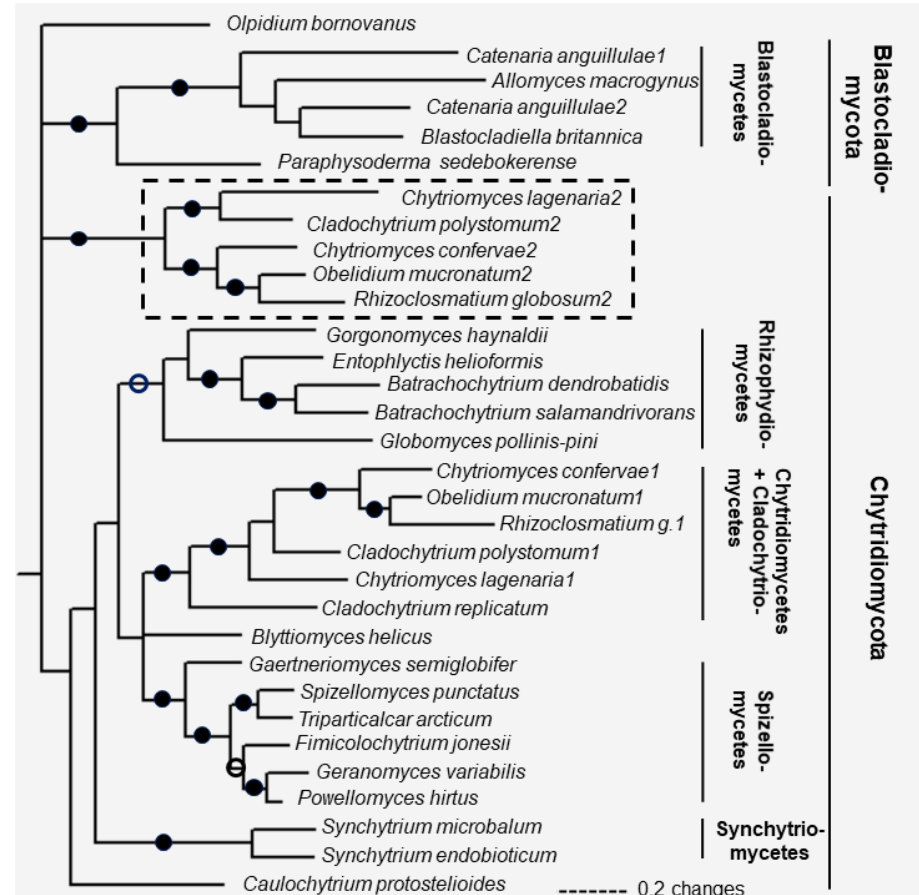
Figure 5. Phylogenetic tree of fungal-type TPPPs constructed by Bayesian analysis. Number of generations was 2.4 × 10 − 6 . Full and open circles at a node indicate that the branch was supported by maximal Bayesian posterior probability (BPP) and ≥ 0.95 BPP, respectively. All the other branches were supported by BPP ≥ 50%. The box with dotted lines includes fungal-type TPPP paralogs being present only in Chytridiomycetes and Cladochytriomycetes. The Accession Numbers of fungal proteins are listed in Table 1.